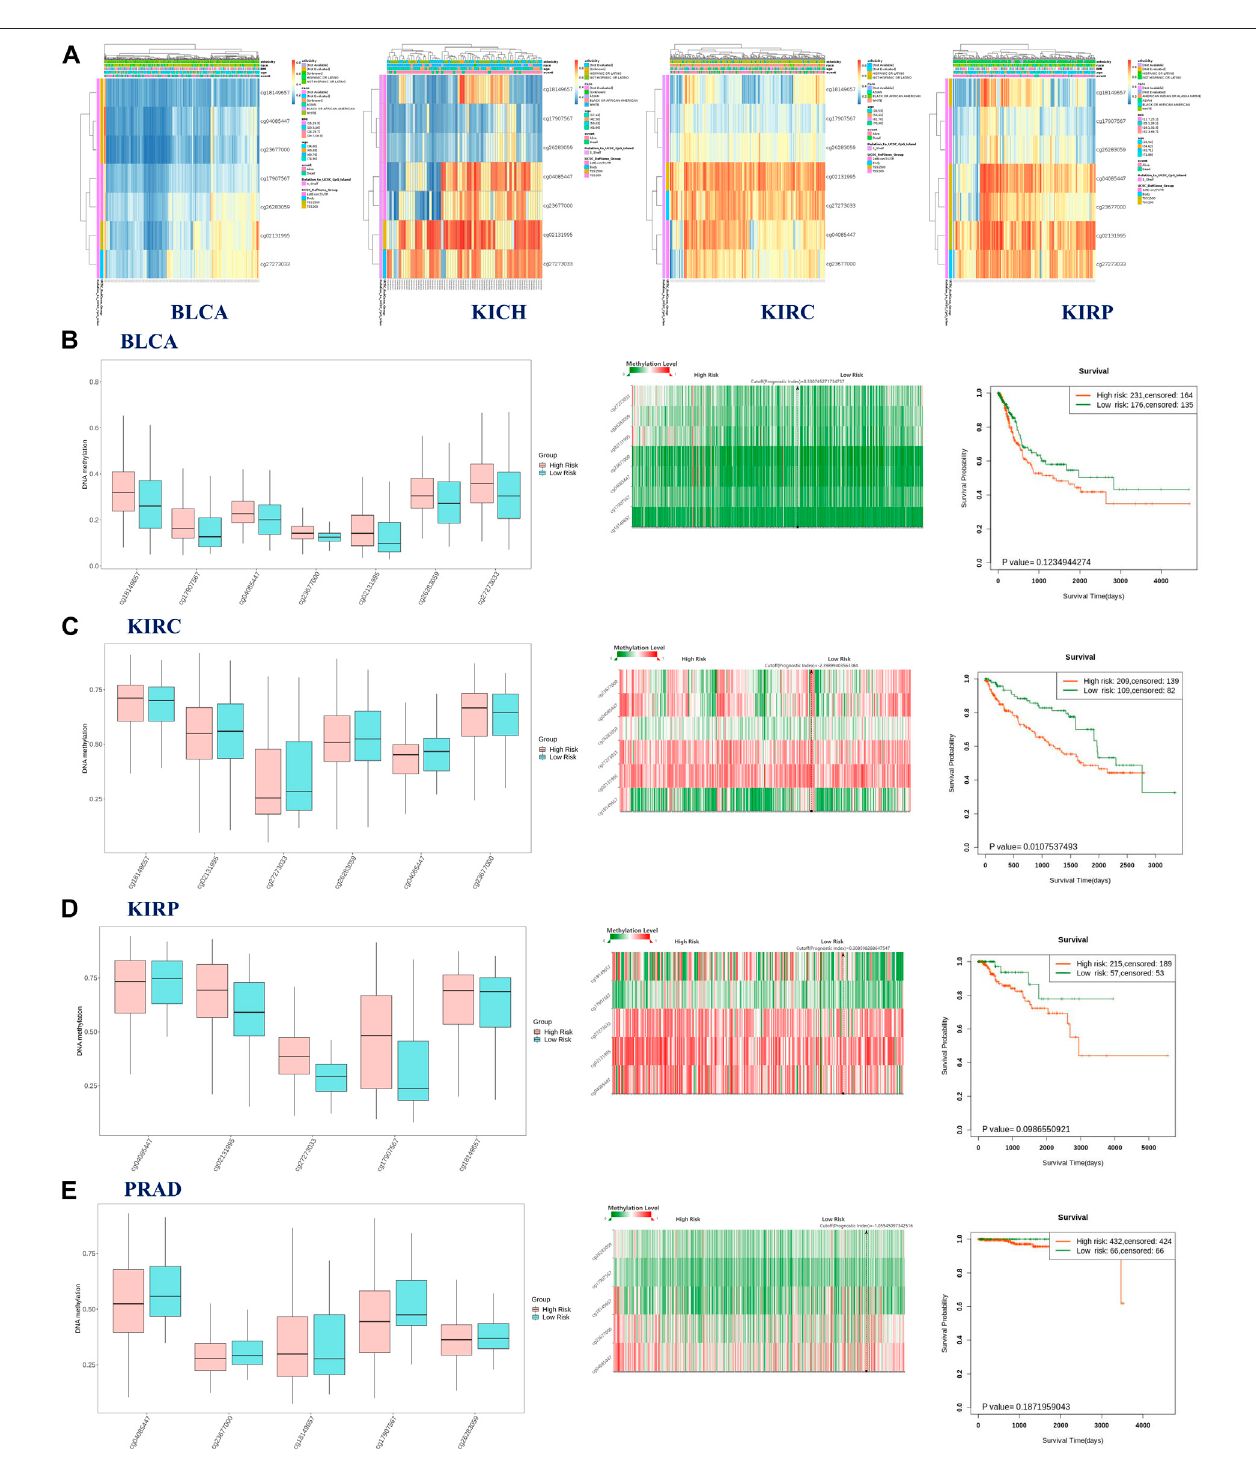
FIGURE 4 | (A) Heatmap of DNA methylation level of hepcidin in bladder urothelial carcinoma (BLCA), kidney chromophobe (KICH), kidney renal clear cell carcinoma (KIRC), and kidney renal papillary cell carcinoma (KIRP). The aforementioned results were analyzed by MethSurv. Results of SurvivalMeth showed the correlation between methylation of CpGs in hepcidin and risk strati fi cation and clinical outcomes in BLCA (B) , KIRC (C) , KIRP (D) , and PRAD (E) . Left panel: the methylation level of CpGs between high- and low-risk groups; middle panel: the heatmap of single CpG methylation level; right panel: the survival curve between high- and low-risk